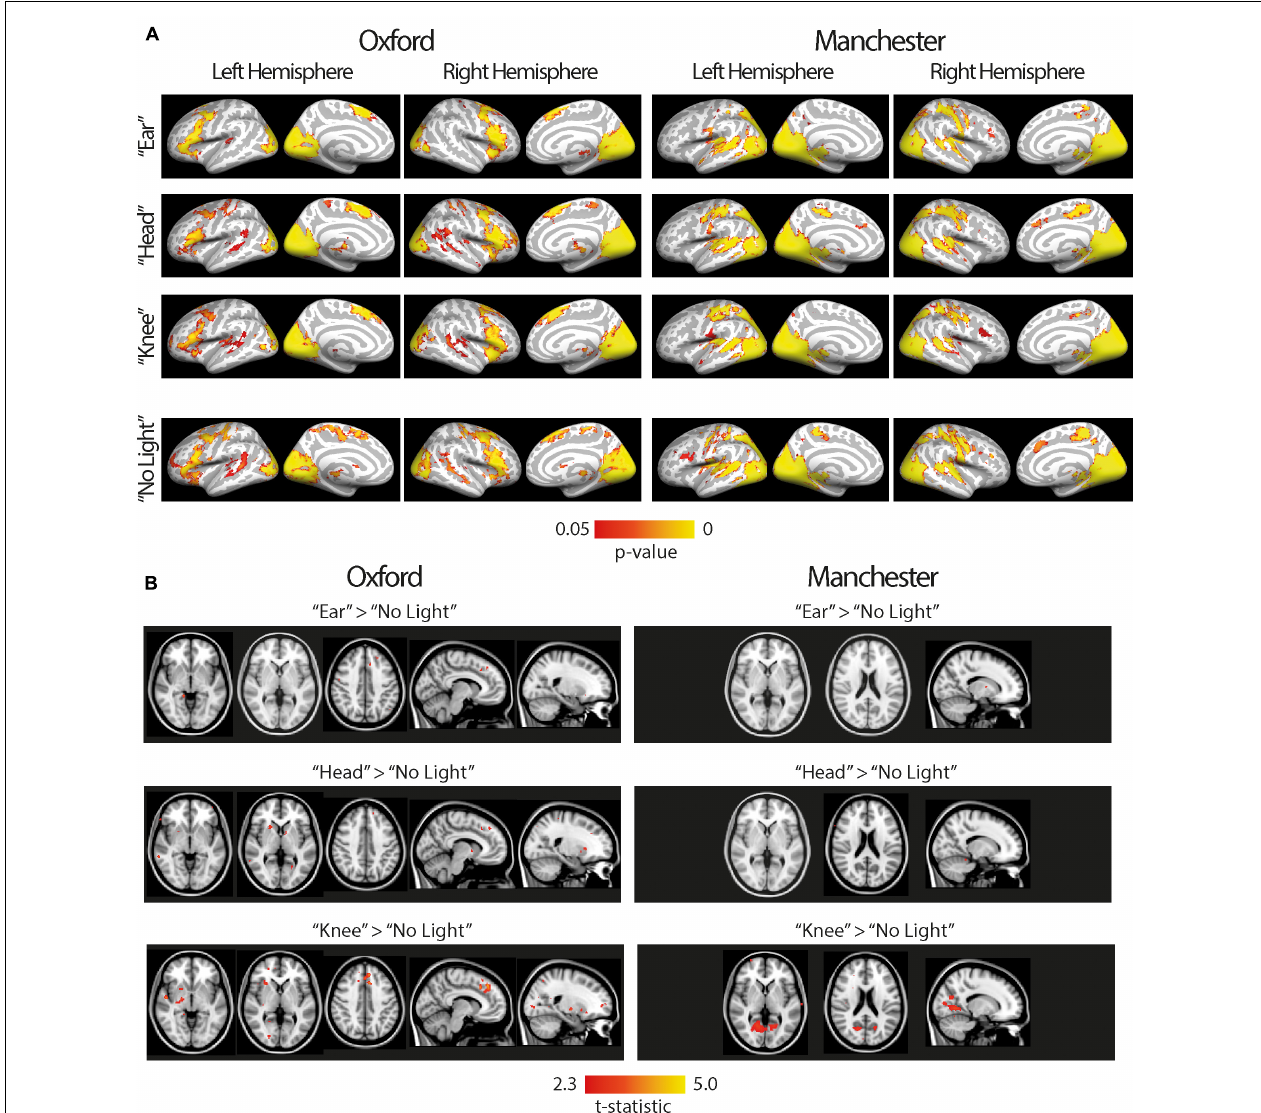
FIGURE 4 | The visual network for all subjects, both anophthalmia and control groups, at Oxford (left) and Manchester (right). (A) Shows brain areas that contribute to the visual network in all four experimental conditions (“ear,” “head,” “knee,” “no light”). For visualization purposes, statistical maps are overlaid using Freesurfer onto the inflated cortical surface of the left and right hemisphere average brain. The color bar shows the p -value range used to display significant functional connectivity, calculated using permutation testing and threshold-free cluster enhancement ( P < 0.05). (B) Shows a contrast of each light condition (“ear,” “head,” “knee”) > “no light” condition. For visualization purposes, statistical maps are overlaid onto the MNI-152 standard brain using FSLview. Since clusters are small and do not survive cluster correction, uncorrected t-statistics are reported ( T >